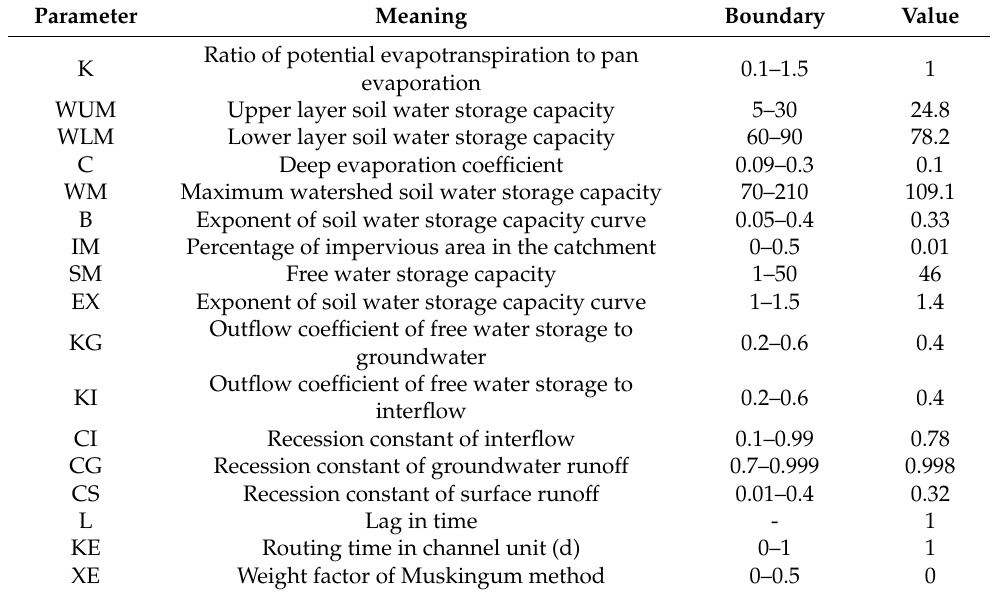
Table A1. Definition of parameters, the boundaries and values of parameters used in this